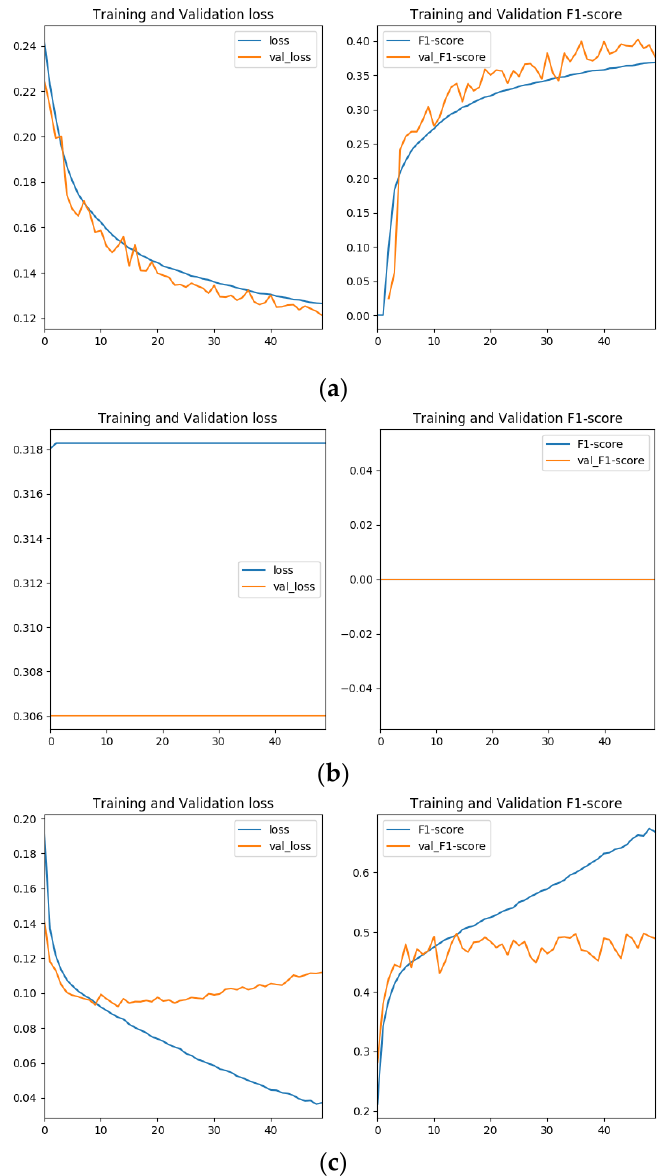
Figure 13. Transitions of loss and accuracy (F1 score) for different optimizers: (a) SGD, (b) Adam and (c) RAdam (k = 10.0, with dropout and without data augmentation).